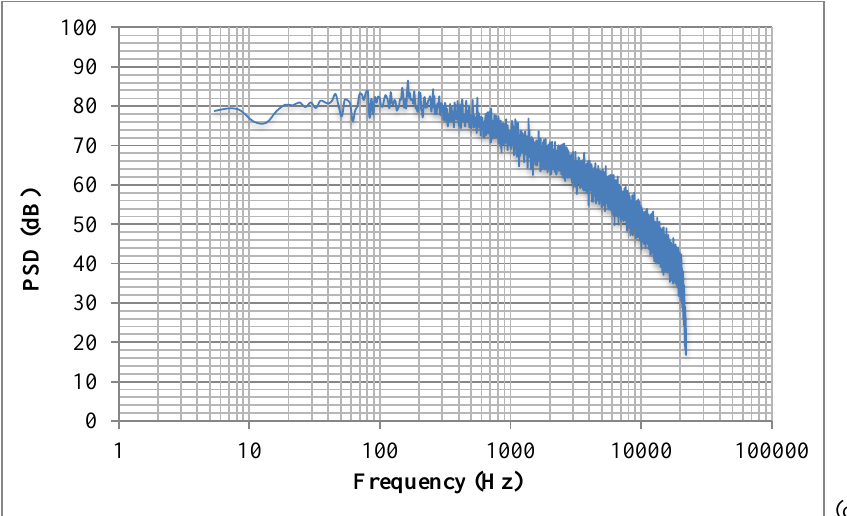
Figure 17. The maximum sound pressure level measured in outdoor test: (a) 80 km/h, (b) 100 km/h, and (c) 120 km/h The maximum sound pressure levels were acquired at 79, 83, and 88 db at 80, 100, and 120 km/h, respectively. The comparison between the original mirror and the modified mirror in measured sound pressure level is demonstrated in Figure 18. The percent reduction in sound pressure levels ranges between 8.13 and 12.87%. It is reached by correction of side mirror geometry and restriction of the fluctuating pressure area and turbulent flow in this zone.